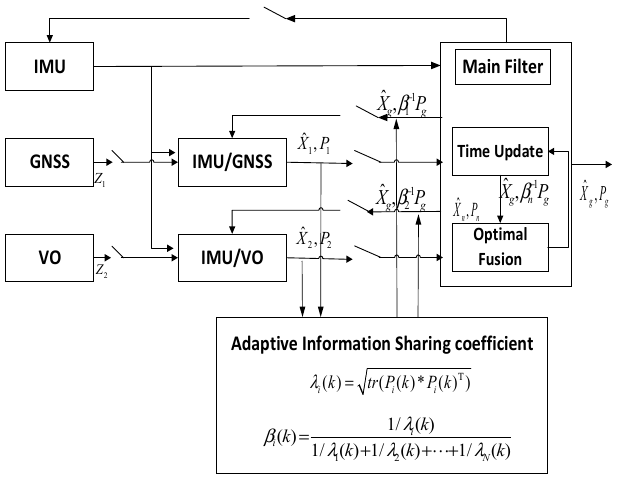
Figure 4. Adaptive federated Kalman filter.